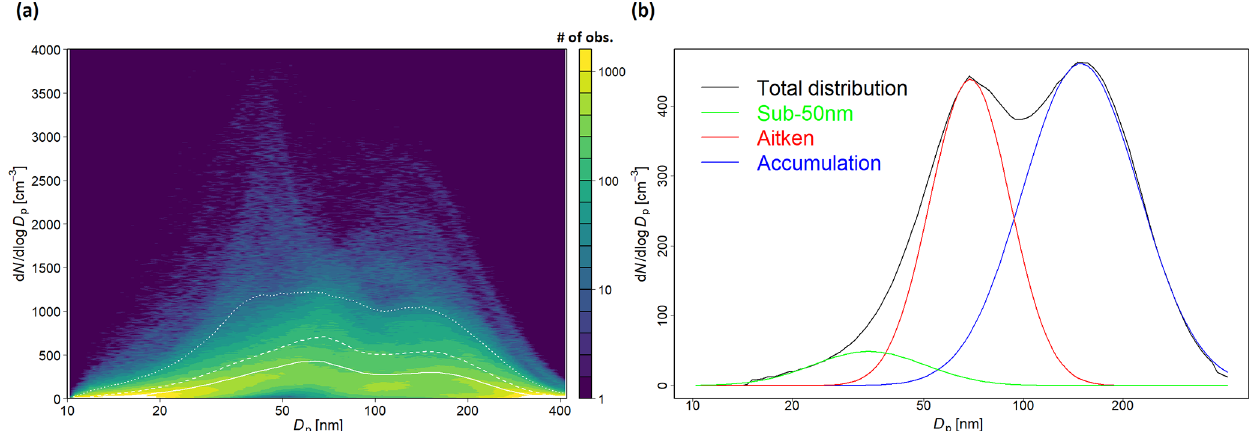
Figure 5. (a) Frequency distribution of particle number size distributions exclusively for growth event periods. The color code denotes the number of observations, solid lines indicate the median, and dashed lines indicate the 75th and 90th percentiles. The PNSDs for the growth events show a high frequency of CN < 50 and Aitken size modes. The FDs do not show any evidence of open PNSDs towards the lower detection limit. (b) Median wet-season PNSD (black line), showing its three log-normal modes: in green, the sub-50nm size particle mode; in red, the Aitken mode; in blue, the accumulation mode; and in black, the total median distribution. The adjusted R 2 obtained for the calculated multi-modal log-normal fit is